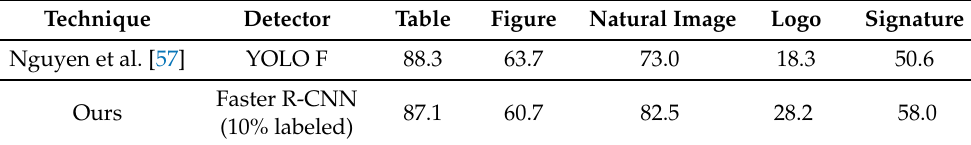
Table 11. Class-wise performance AP (0.5:0.95) comparison of YOLO F baseline model trained using fully labeled data with our model, which is equipped with Faster-RCNN and ResNet50 and is trained on 10% labeled